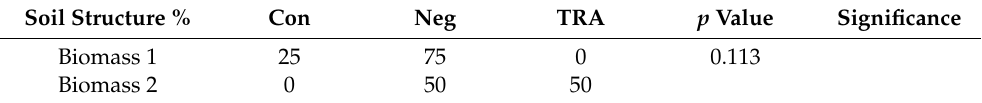
Table 3. Percentage of structure of the two areas. Con = Considerable, Neg = Negligible, TRA = Trace. Soil Structure